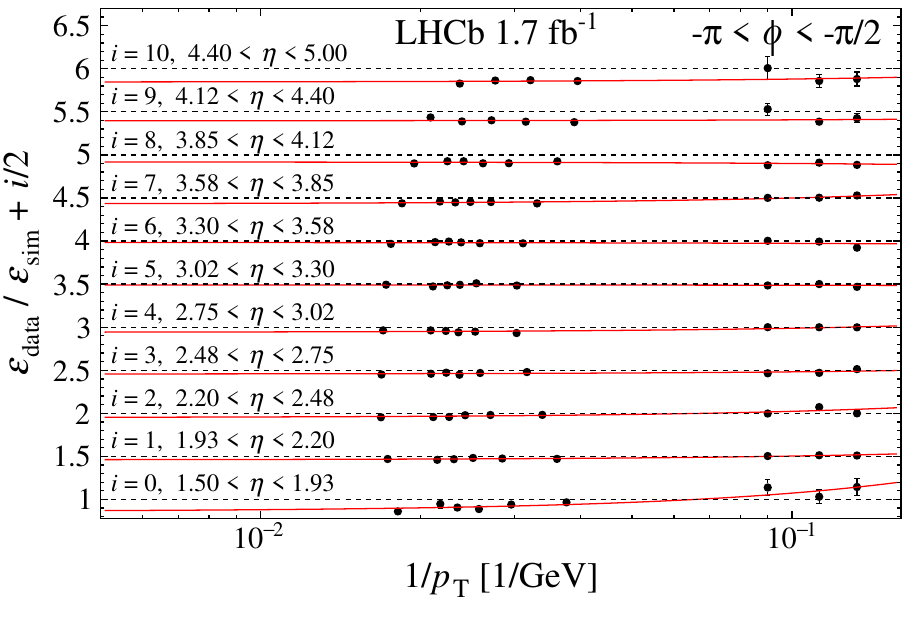
Figure 4 . Trigger efficiency ratios in data relative to simulation in intervals of η for a single interval of φ . The points are presented as a function of 1 /p and are overlaid with best-fit linear functions of T p T . Points from each η interval are separated for readability by an offset of half the integer index i for that interval. The uncertainties on most of the points are too small for the error bars to be